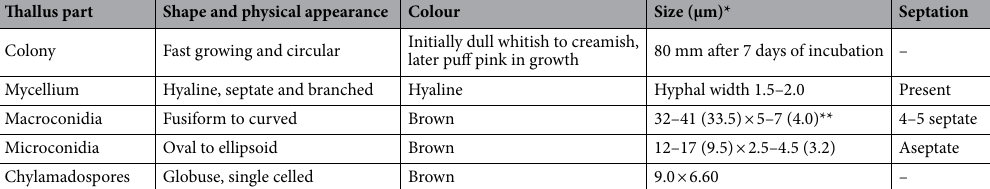
Table 1. Morpho-cultural characteristics of isolated pathogen. *Values are means of 15 replications. **values in parenthesis are mean